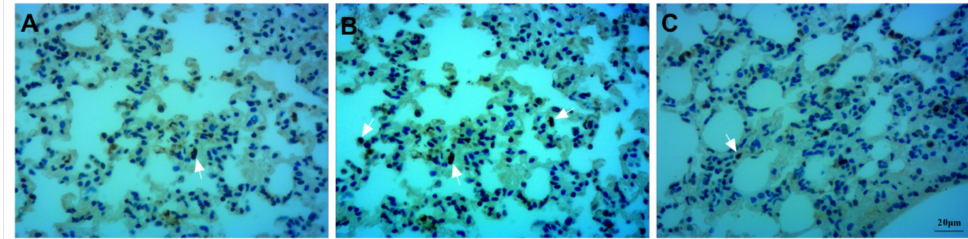
Figure 6. Detection of apoptosis in lung tissue: ( A ) Con group; ( B ) Bl group; ( C ) Bl + MSC group; TUNEL staining revealed apoptosis in lung tissue. White arrows indicate apoptotic cells ( A – C , 400 × magnification).